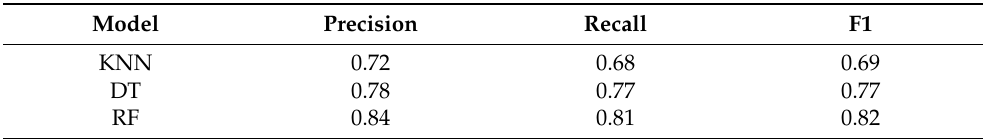
Table 4. ML classification performances for the “Prosilio” landslide site. Applied